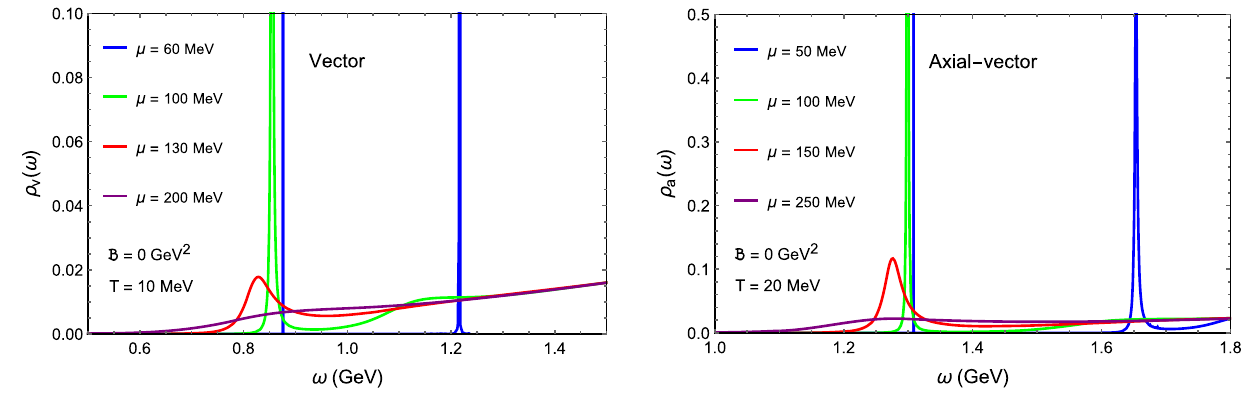
Fig. 5 The spectral functions ρ v (ω) and ρ a (ω) for four different chemical potentials at fixed B and T